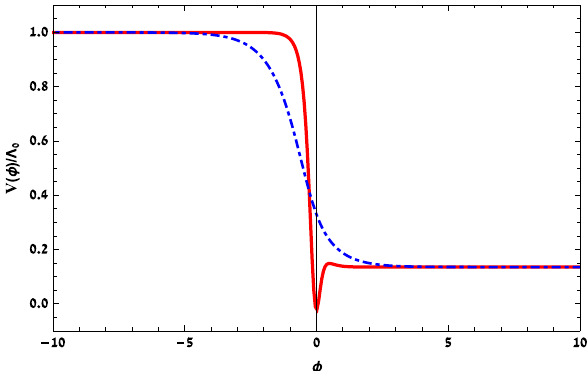
Fig. 3 The corresponding scalar-field potential for the Lorentzian ansatz, with different values of Γ : 0 . 1 red smooth line, 1 blue dashed